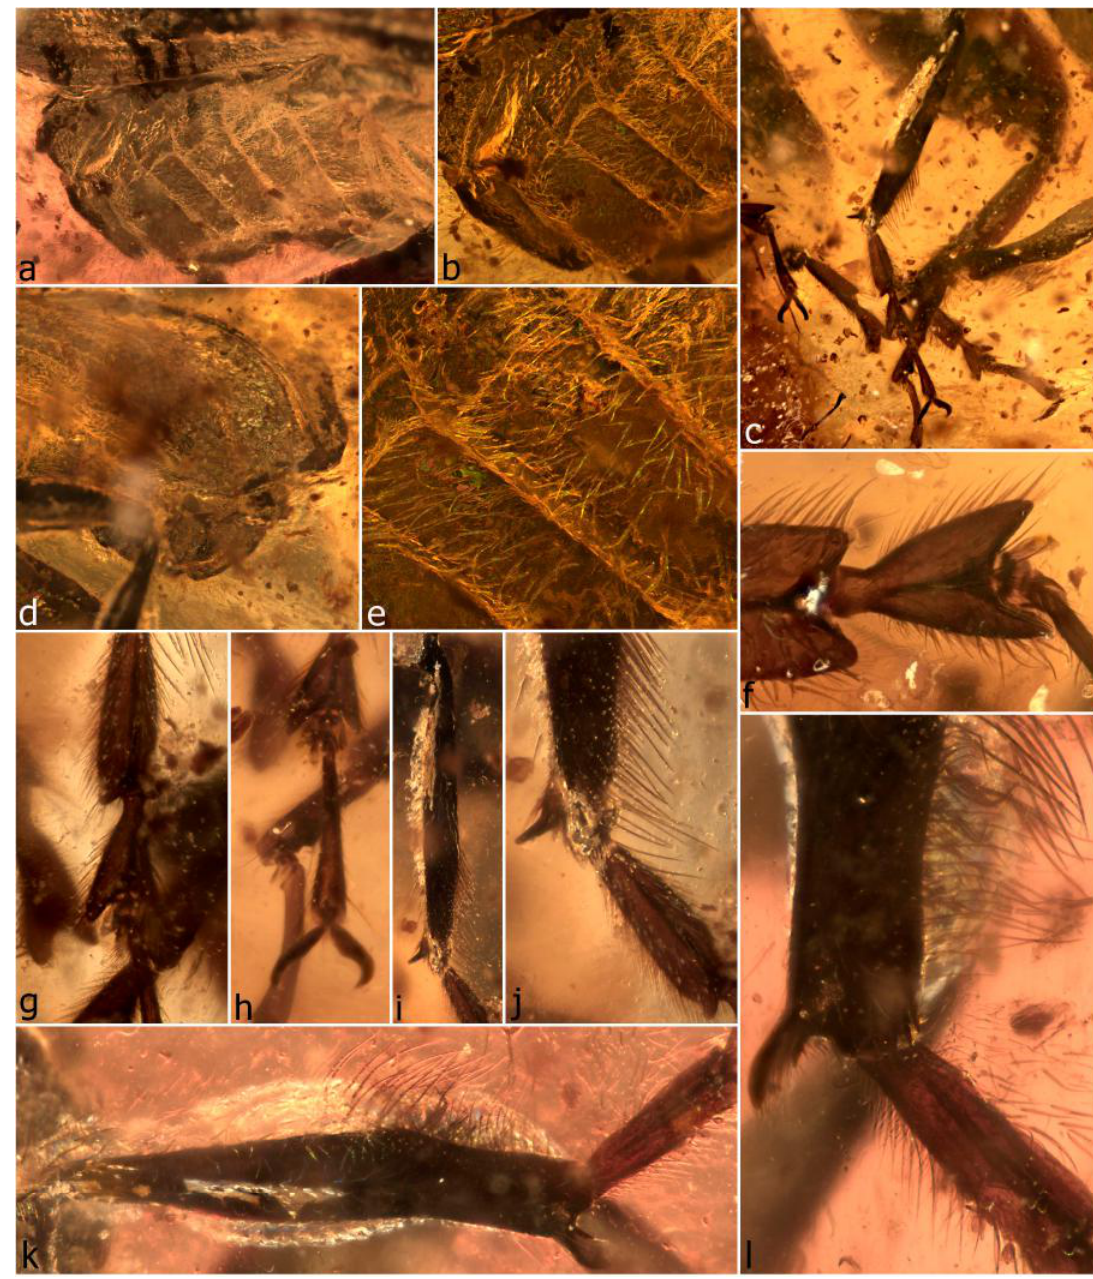
Figure 45. Echogomphus viridescens sp. n., holotype. Ventrites, ventrolateral ( a ); detail of ventrites, ventrolateral ( b ); legs ( c ); apex of elytra and pygidium, ventrolateral ( d ); detail of ventrites and iridescent setae ( e ); apex of tarsite 1, tarsites 2 and 3 and base of 5, showing broken peduncle of 3, dorsal ( f ); left mesotarsites 1 and 2, dorsal ( g ); left mesotarsal claws, dorsal ( h ); left mesotibia showing apical spur ( i ); same, apical part ( j ); left metatibia showing larger apical spike and smaller spur ( k ); detail of metatibial spike and spur ( l ).